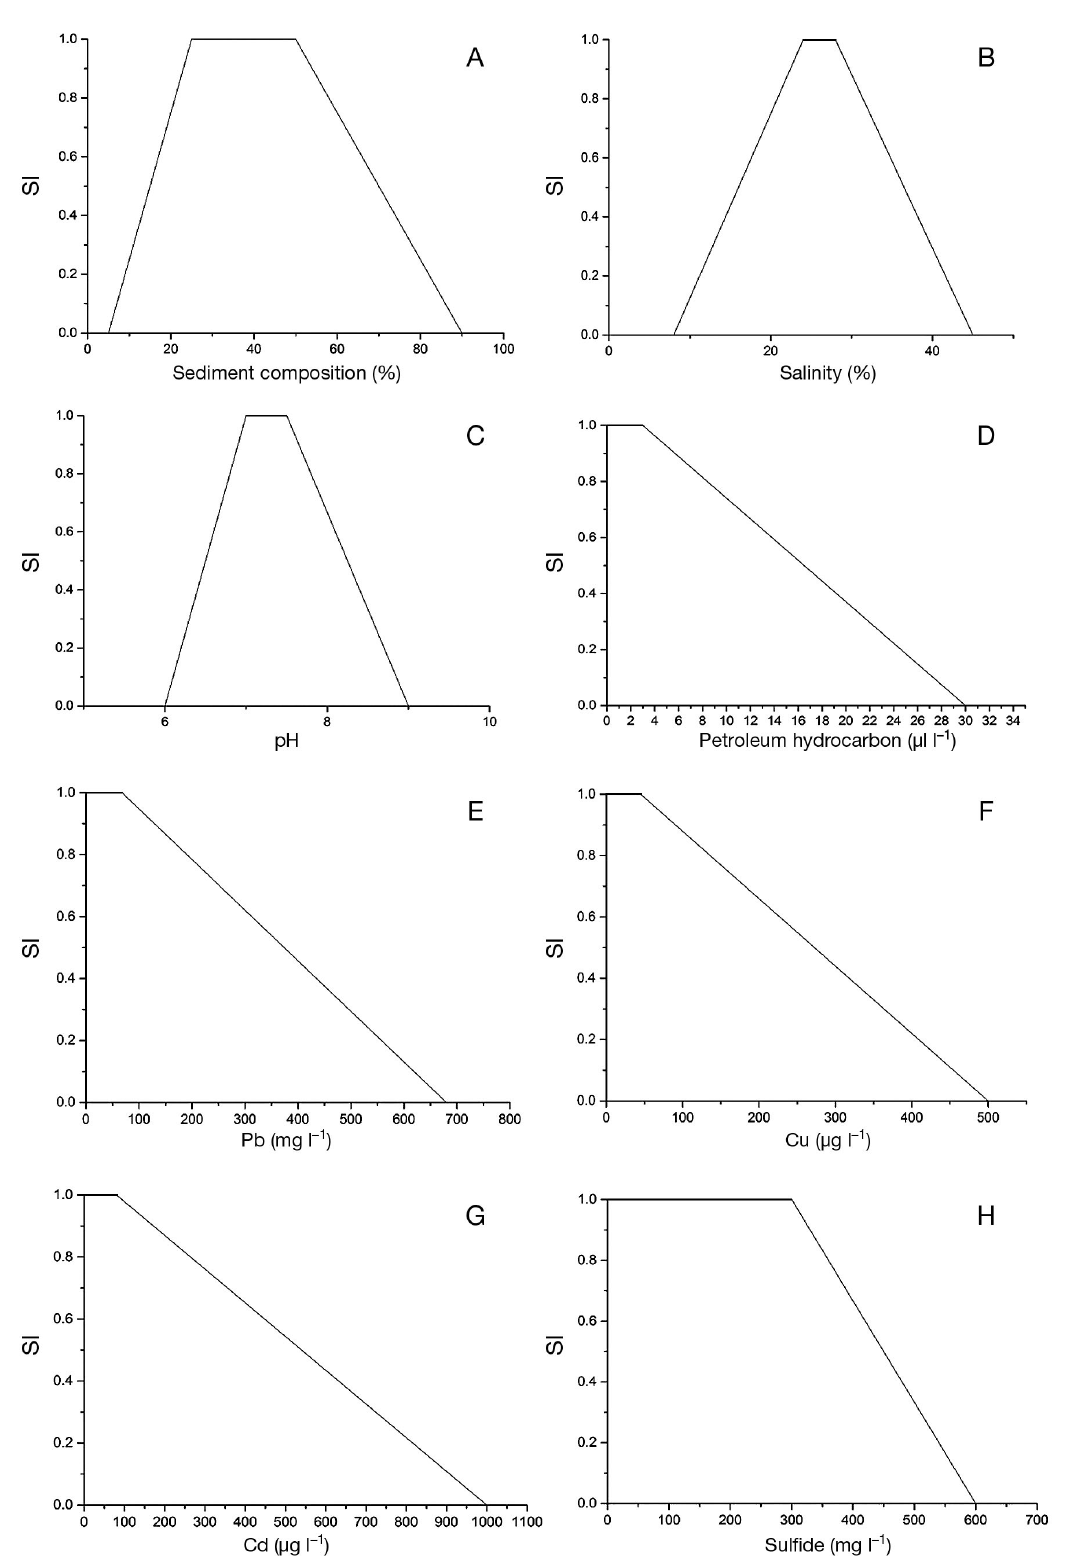
Fig. 3. Parameter factor suitability functions for: (A) sand content; (B) salinity; (C) pH; (D) petroleum hydrocarbon; (E) lead; (F) copper; (G) cadmium; and (H) sulfide. SI, suitability